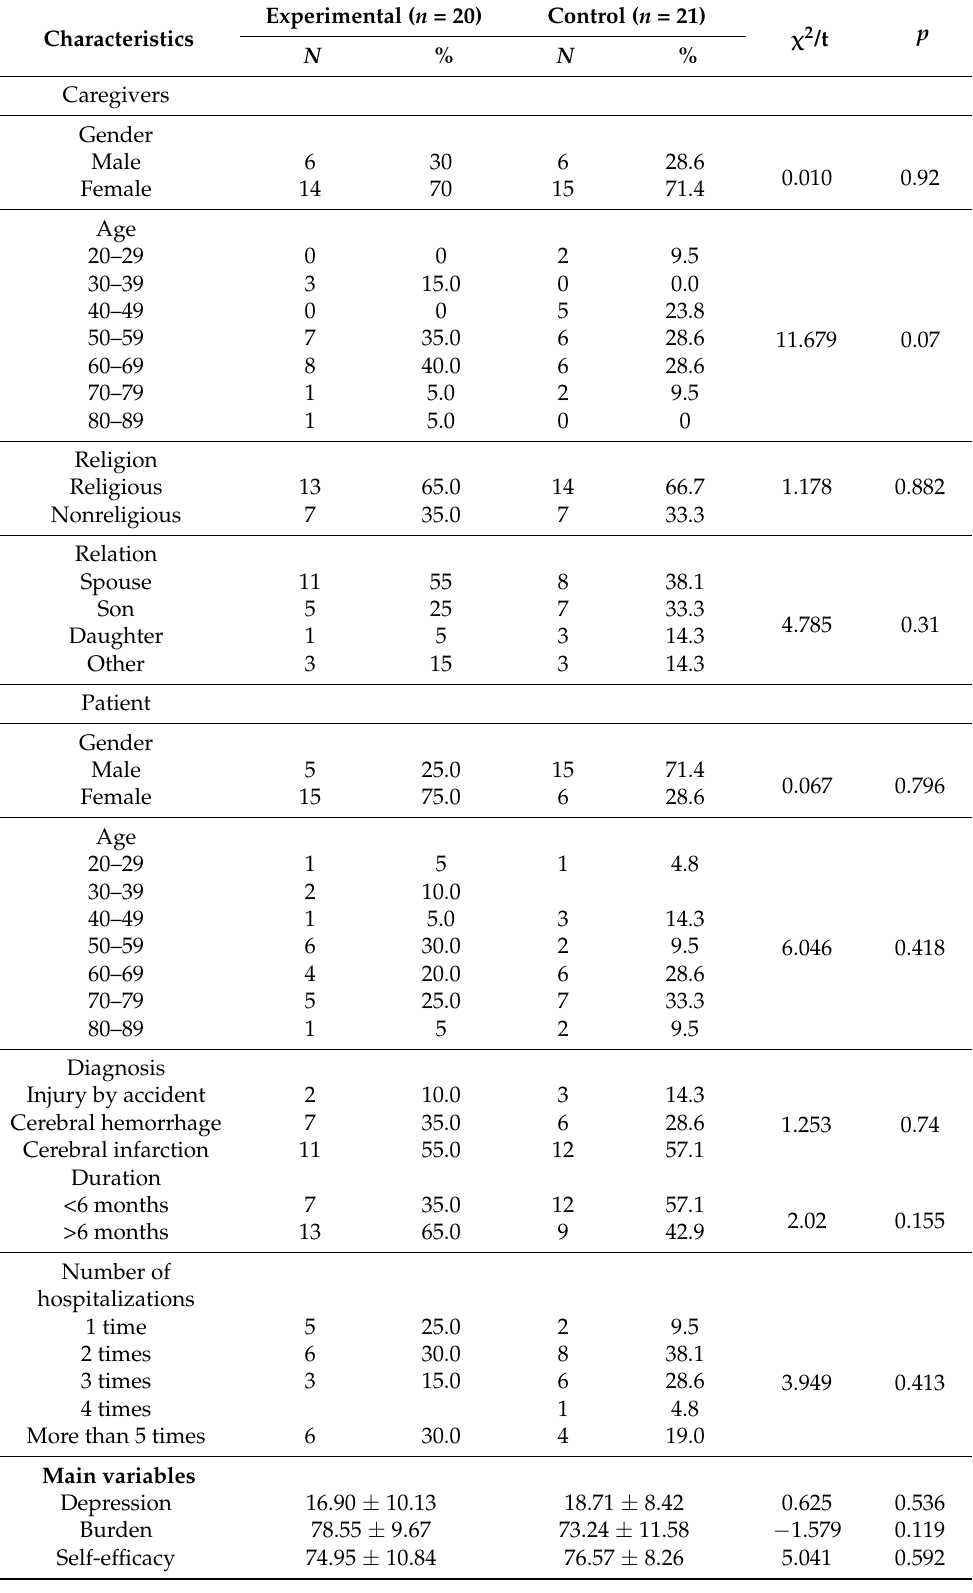
Table 2. Results of the homogeneity test on the two groups’ demographic characteristics and outcome variables ( n =